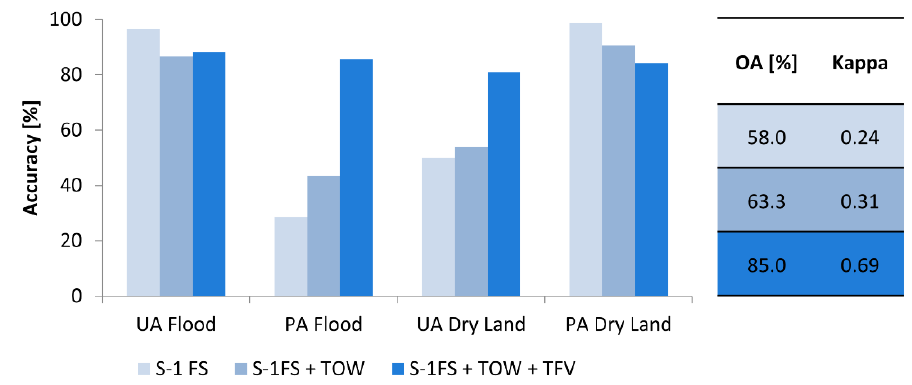
Figure 14. Accuracy assessment results based on the S-1FS and its improvement (S-1FS + TOW and S-1FS + TOW + TFV).